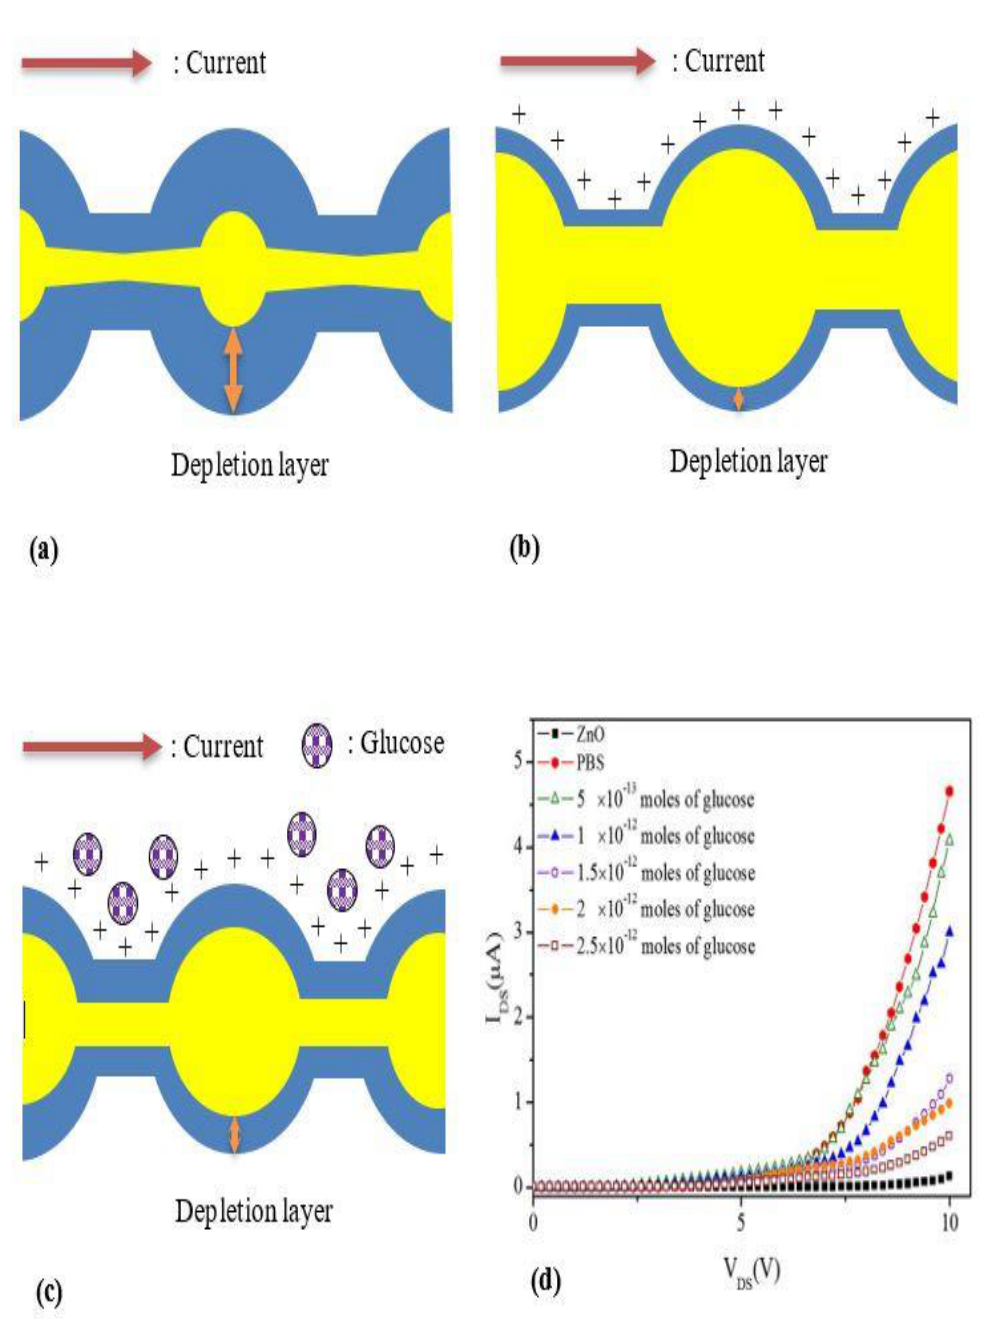
Figure 5. Redrawing of the sensing system of glucose concentration directly using ZnO nanoparticles ( a ) early condition of ZnO nanoparticles channel, ( b ) reduction of the depletion layer of the ZnO nanoparticles channel after immersion in phosphate-buffered saline solution, ( c ) increase of the depletion layer in the ZnO nanoparticles channel with phosphate-buffered saline after addition with glucose solution, and ( d ) current – voltage plot for glucose biosensors with different concentrations of glucose show that current value is inversely proportional to glucose concentration. Reprinted from [65]. Copyright 2011, with permission from Elsevier.